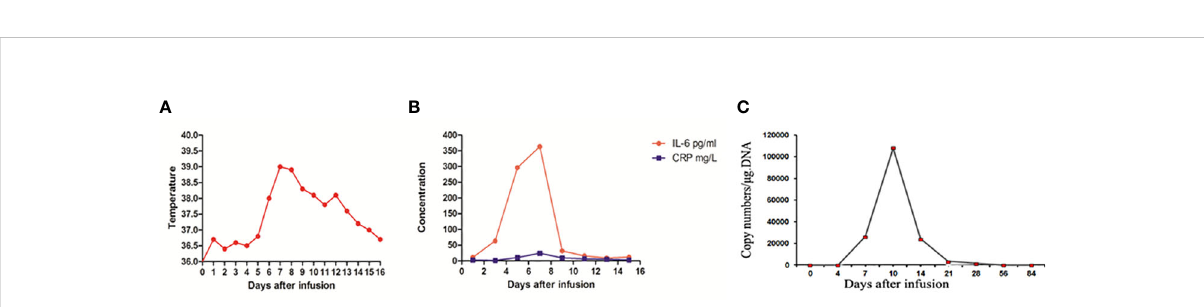
FIGURE 2 Clinical evolutions after CAR-T cells infusion. (A) Measures of body temperature after CAR-T cells infusion, the plot showed the maximum temperature was 39°C on day 7. (B) Levels of cytokines IL-6 and CRP were monitored at the indicated time points after CAR-T cells infusion. IL- 6 and CRP peaked on day 7. (C) The vector copy number of anti-CD19 CAR in peripheral blood was detected by PCR. The highest anti-CD19 CAR DNA copy number was 108,140 copies/µg DNA on day 10. IL-6, interleukin-6; CRP, C reactive protein; PCR, polymerase chain reaction.